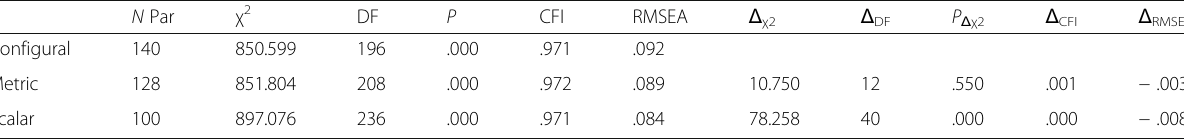
Table 3 Measurement invariance